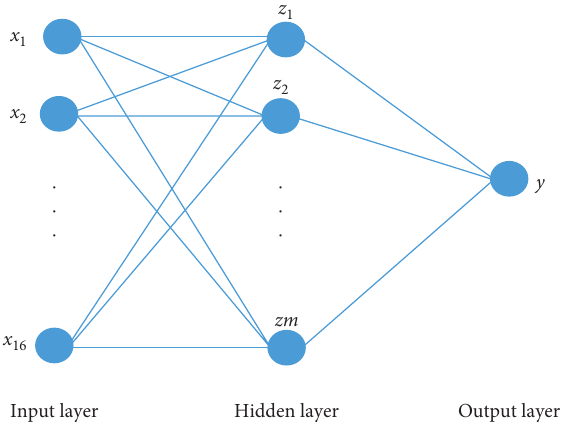
Figure 2: Backpropagation neural network